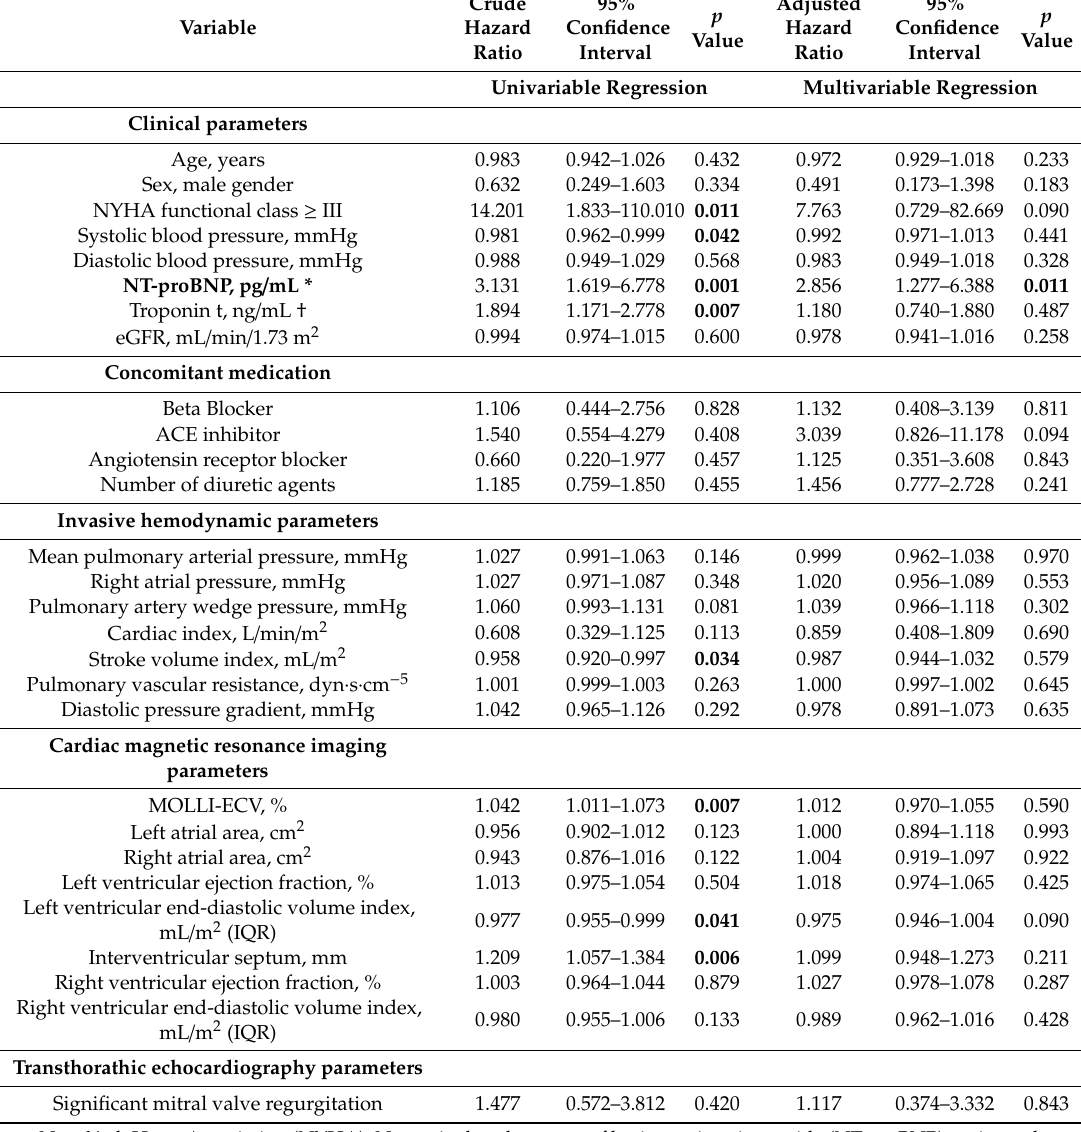
Table 3. Cox regression analysis for the cardiac light-chain amyloidosis